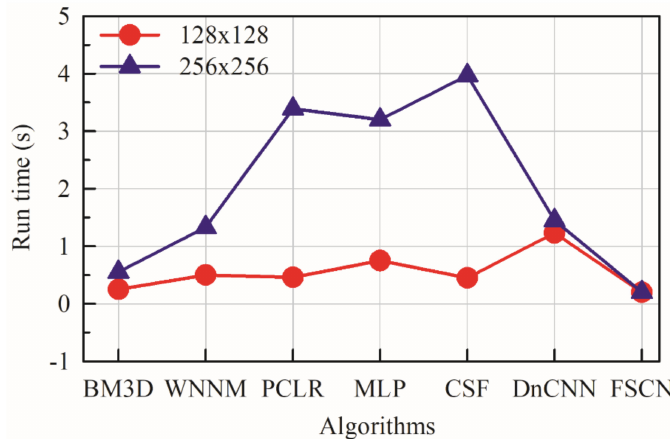
Figure 12. Run time of different methods on images of size 128 × 128 and 256 × 256 with noise level